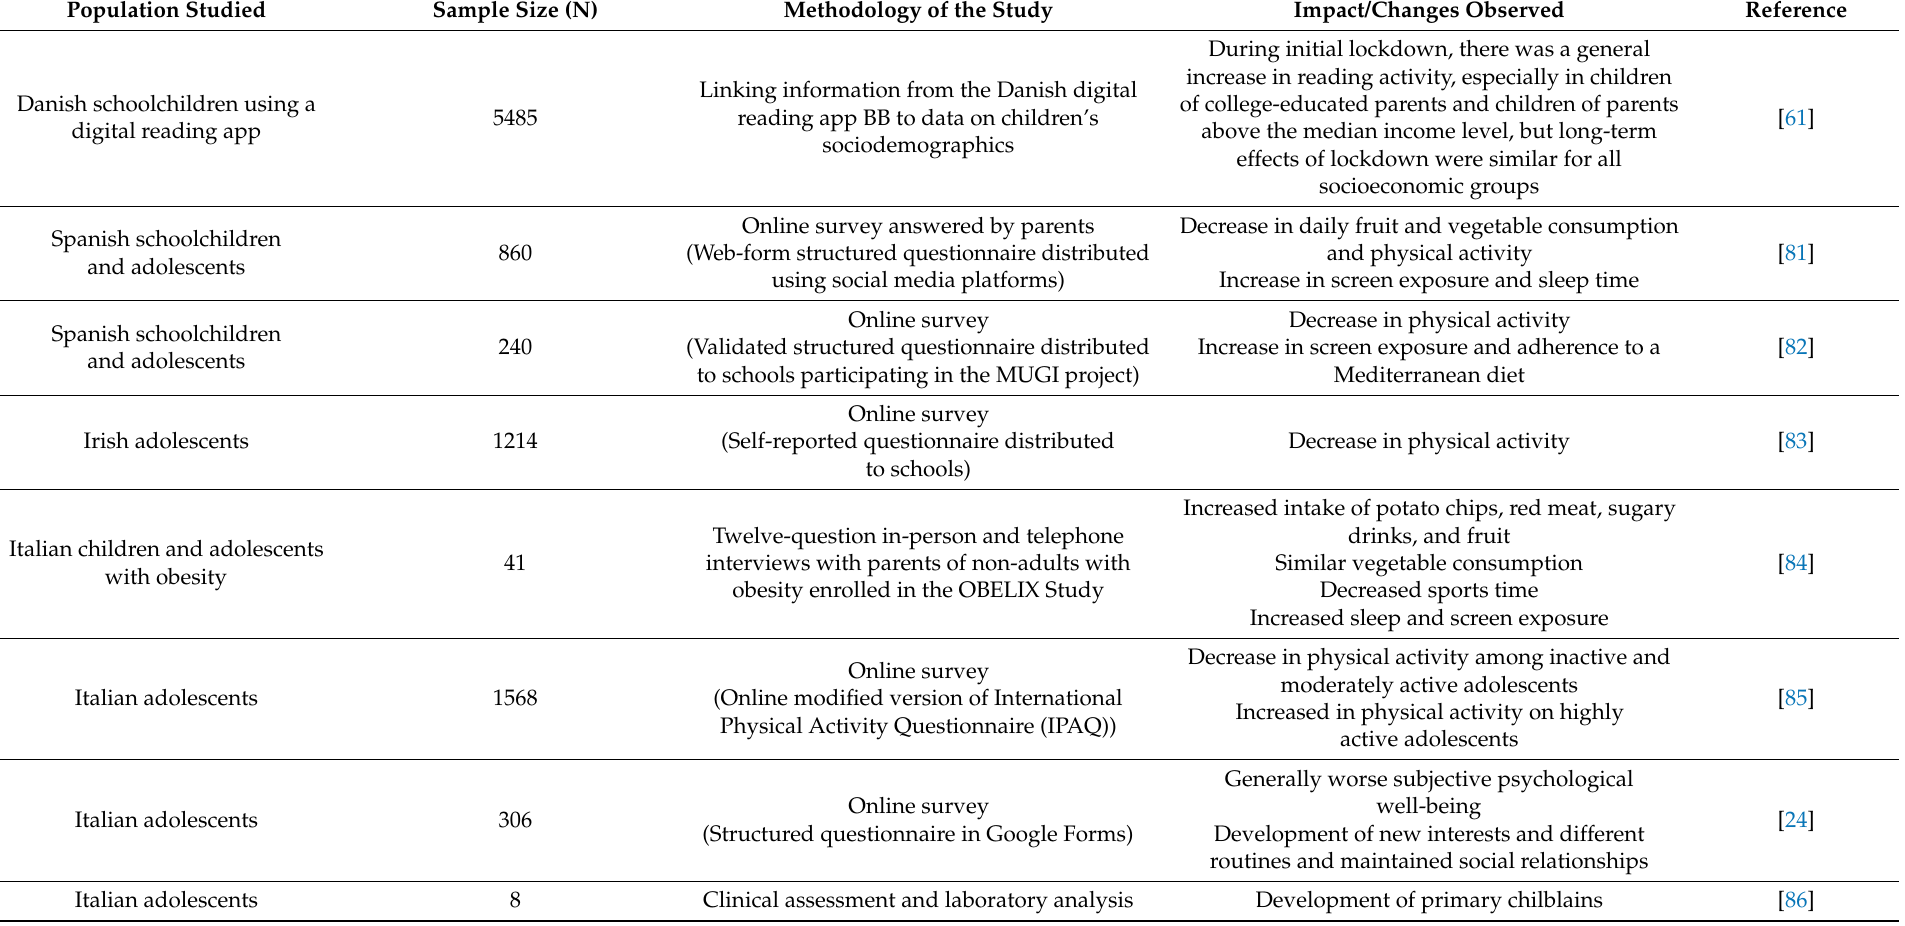
Table 3. Brief summary of studies related to the consequences of the lockdown in European